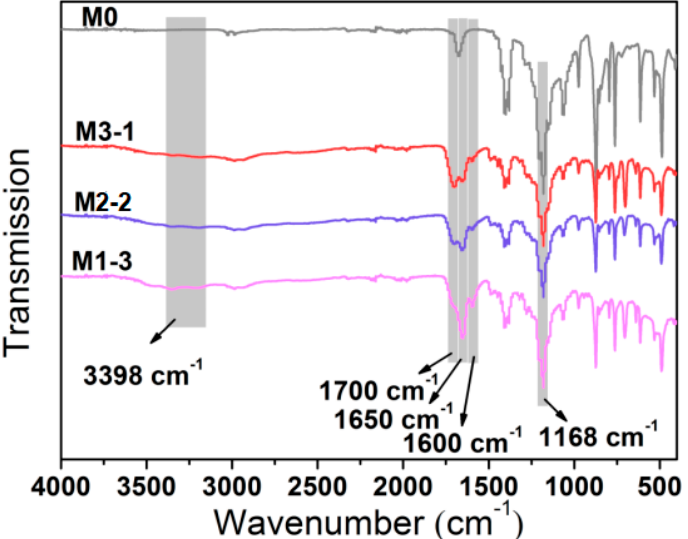
Figure 2. Attenuated total reflection Fourier transform infrared spectrum (ATR-FTIR) spectra of M0, M3-1, M2-2, and M1-3.